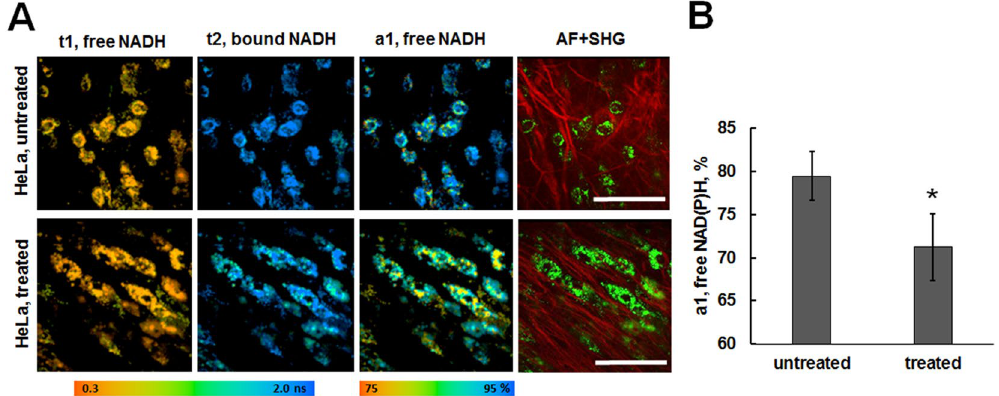
Figure 6. In vivo two-photon FLIM of NAD(P)H in HeLa tumors in response to cisplatin. ( A ) Fluorescence lifetimes of NAD(P)H (short t1 and long t2 components), relative amplitude of the short component (free NAD(P)H, a1, %), and overlapping of two-photon excited autofluorescence (AF, green, excitation at 750 nm, detection 410–660 nm) and SHG from collagen (red, excitation at 750 nm, detection - 373–387 nm). ( B ) Relative amplitude a1% of free NAD(P)H calculated from the in vivo FLIM images. * Statistically significant difference from the untreated control, p ≤ 0.05, mean ± SD, n = 3 tumors (the calculations were made for 50–75 cells in each tumor). FLIM was performed on the 35 th day of tumor growth (3 days after the final cisplatin dose). For FLIM of NAD(P)H: ex. 750 nm, reg. 410–660 nm, image collection time was 10 seconds. Bar is 100 µ m (applicable to all